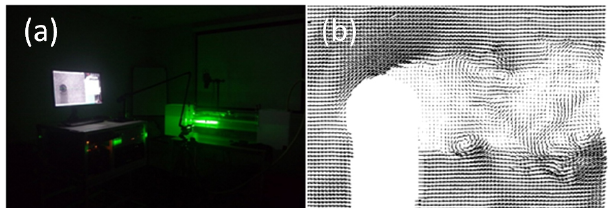
Figure 2. PIV measurements of the flow around a cylinder. (a) On the right the flume with a cylinder being lighted by the laser and, on the left, on the monitor, the obtained flow image in real time. (b) The obtained velocity map. PIV system courtesy of ILA5150 (W.A.T.E.R.